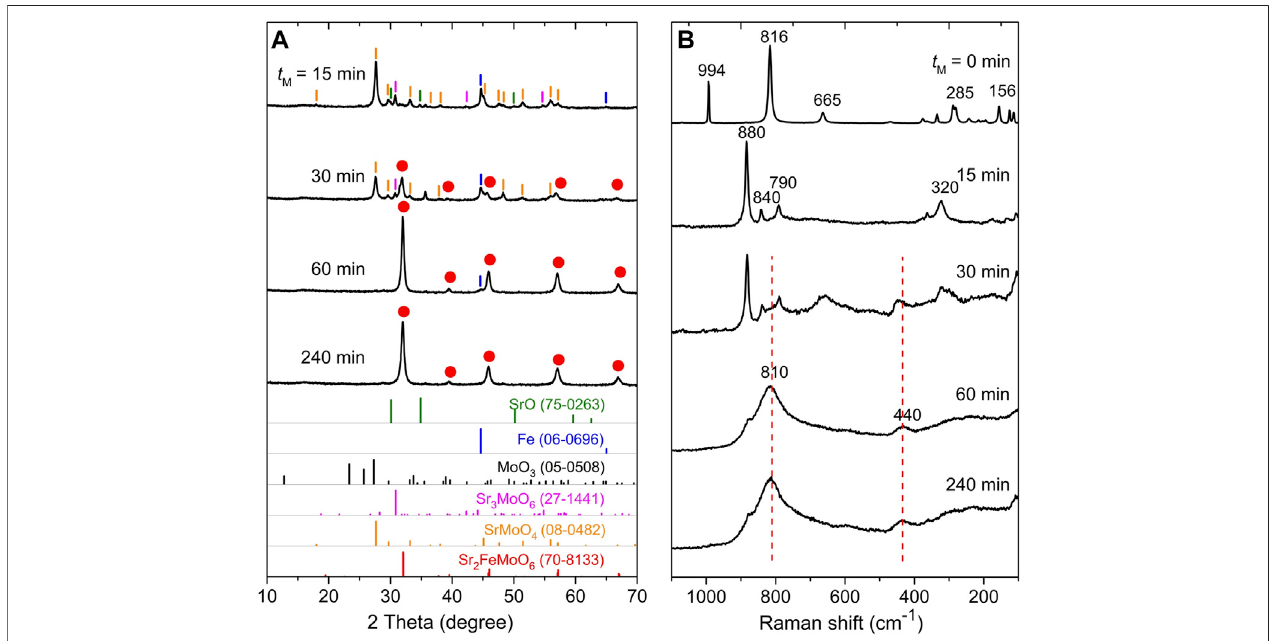
FIGURE 2 | (A) XRD patterns and (B) Raman spectra of the 2 SrO + α -Fe + MoO 3 mixture milled for various times ( t M ) up to 240 min in air. The mechanochemical reaction2SrO+ α -Fe+MoO 3 +½O 2 → → Sr 2 FeMoO 6 proceedsthroughtheformationofintermediatephasesSrMoO 4 andSr 3 MoO 6 .ThetheoreticalBragg peak positionswiththeICDD PDF numbers correspondingtothereactionprecursors, intermediate phases and the product phase arepresentedat the bottom ofpanel 2A. The positions of Raman peaks associated with the formed Sr 2 FeMoO 6 phase are indicated in Panel 2B by the dashed lines.